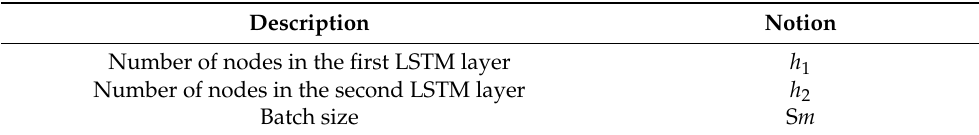
Table 1. Optimized Parameters. Description